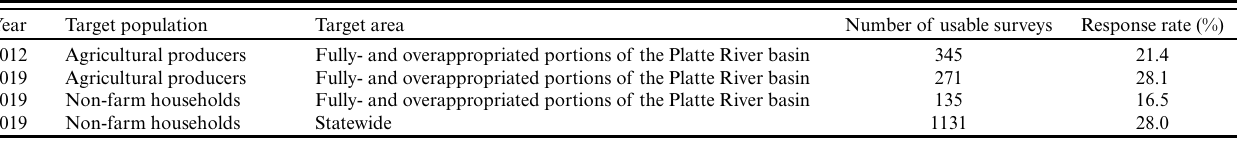
Table 1. Brief comparison of the four surveys used in this